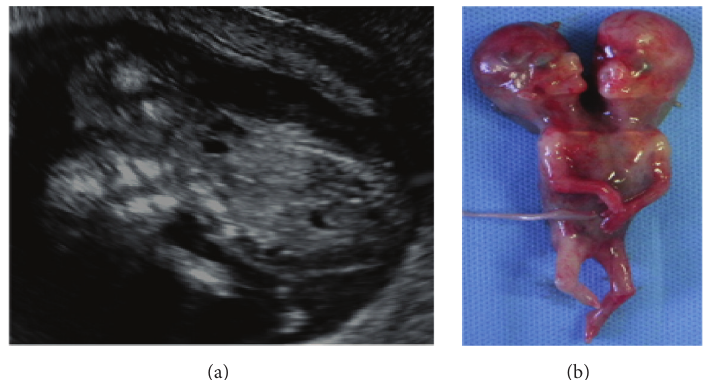
Figure 1: (a) Ultrasound showing twin gestation with fusion of the thorax and abdomen; (b) ex vivo photograph showing dicephalus parapagus conjoined